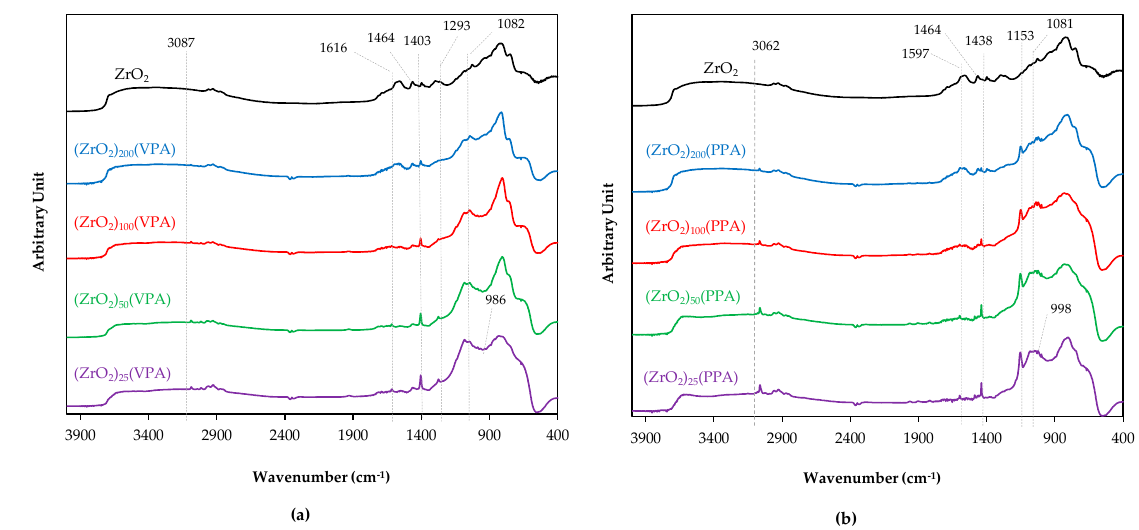
Figure 2. Infrared spectroscopy (DRIFT) spectra of ( a ) (ZrO 2 ) x (VPA) and ( b ) (ZrO 2 ) x (PPA) samples (Zr/P ratio ( x ) = 25, 50, 100, 200) and bare ZrO 2 .